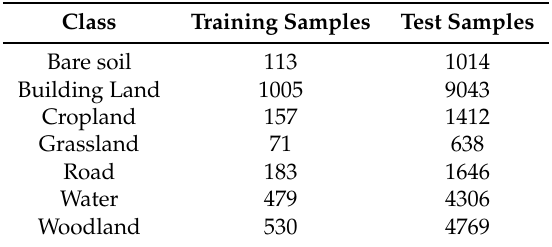
Table 1. Ground Reference in units of pixels for each of the